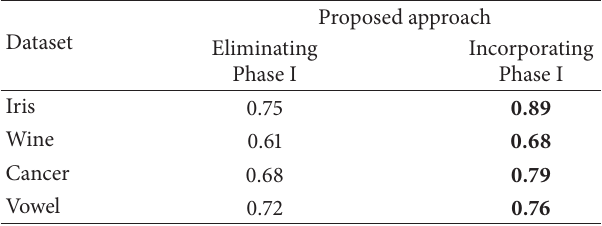
Table 1: Accuracy of proposed method.